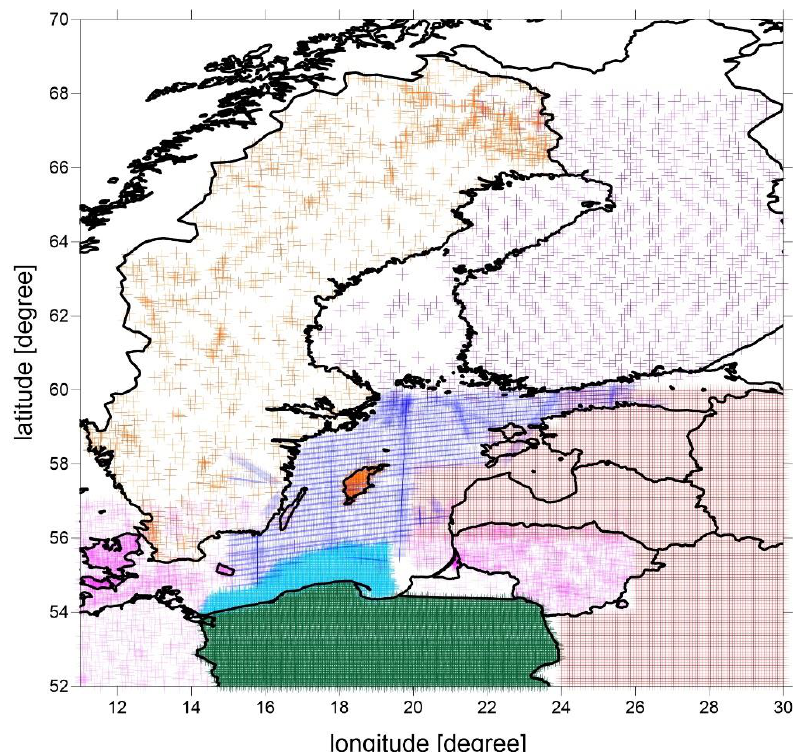
Figure 2. Distribution of gravity data (markings in a figure: GREEN CROSS: mean Faye's from the Institute of Geodesy and Cartography in Warsaw; LIGHT BLUE CROSS: mean free-air anomalies from the Space Research Centre PAS; VIOLET CROSS: from the Finish Geodetic Institute; ROSE CROSS: shipborne gravity and land data from Kort and Matrikelstyrelsen in Denmark; BROWN CROSS: gravity data from the Bureau Gravimétrique International; DARK BLUE CROSS: gravimetric data from GETECH; PURPLE CROSS: airborne gravity data were from Kort and Matrikelstyrelsen in Denmark). Table 1. Statistics of the gravity data used in this study (in mGal).